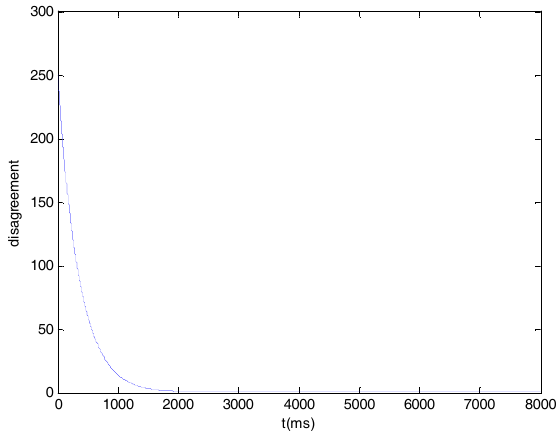
Figure 4. State trajectories and the disagreement function (cid:107) δ (cid:107) 2